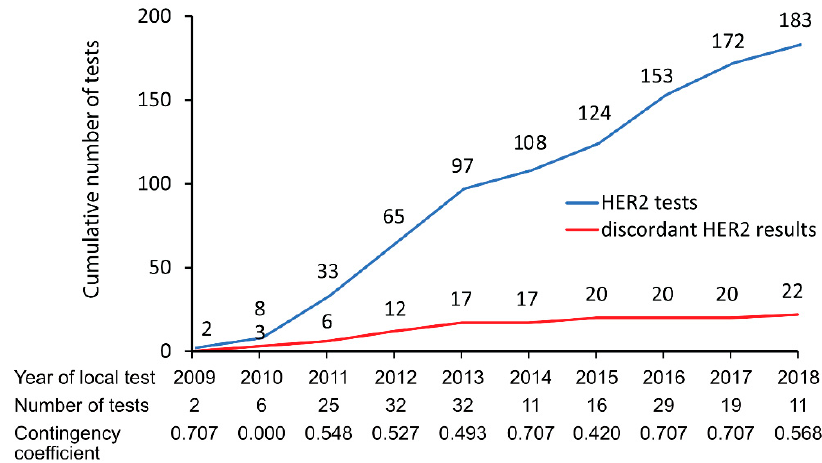
Figure 2. HER2 discordance rate according to local HER2 testing year. Blue line: cumulative HER2 tests, red line: cumulative discordant HER2 results.